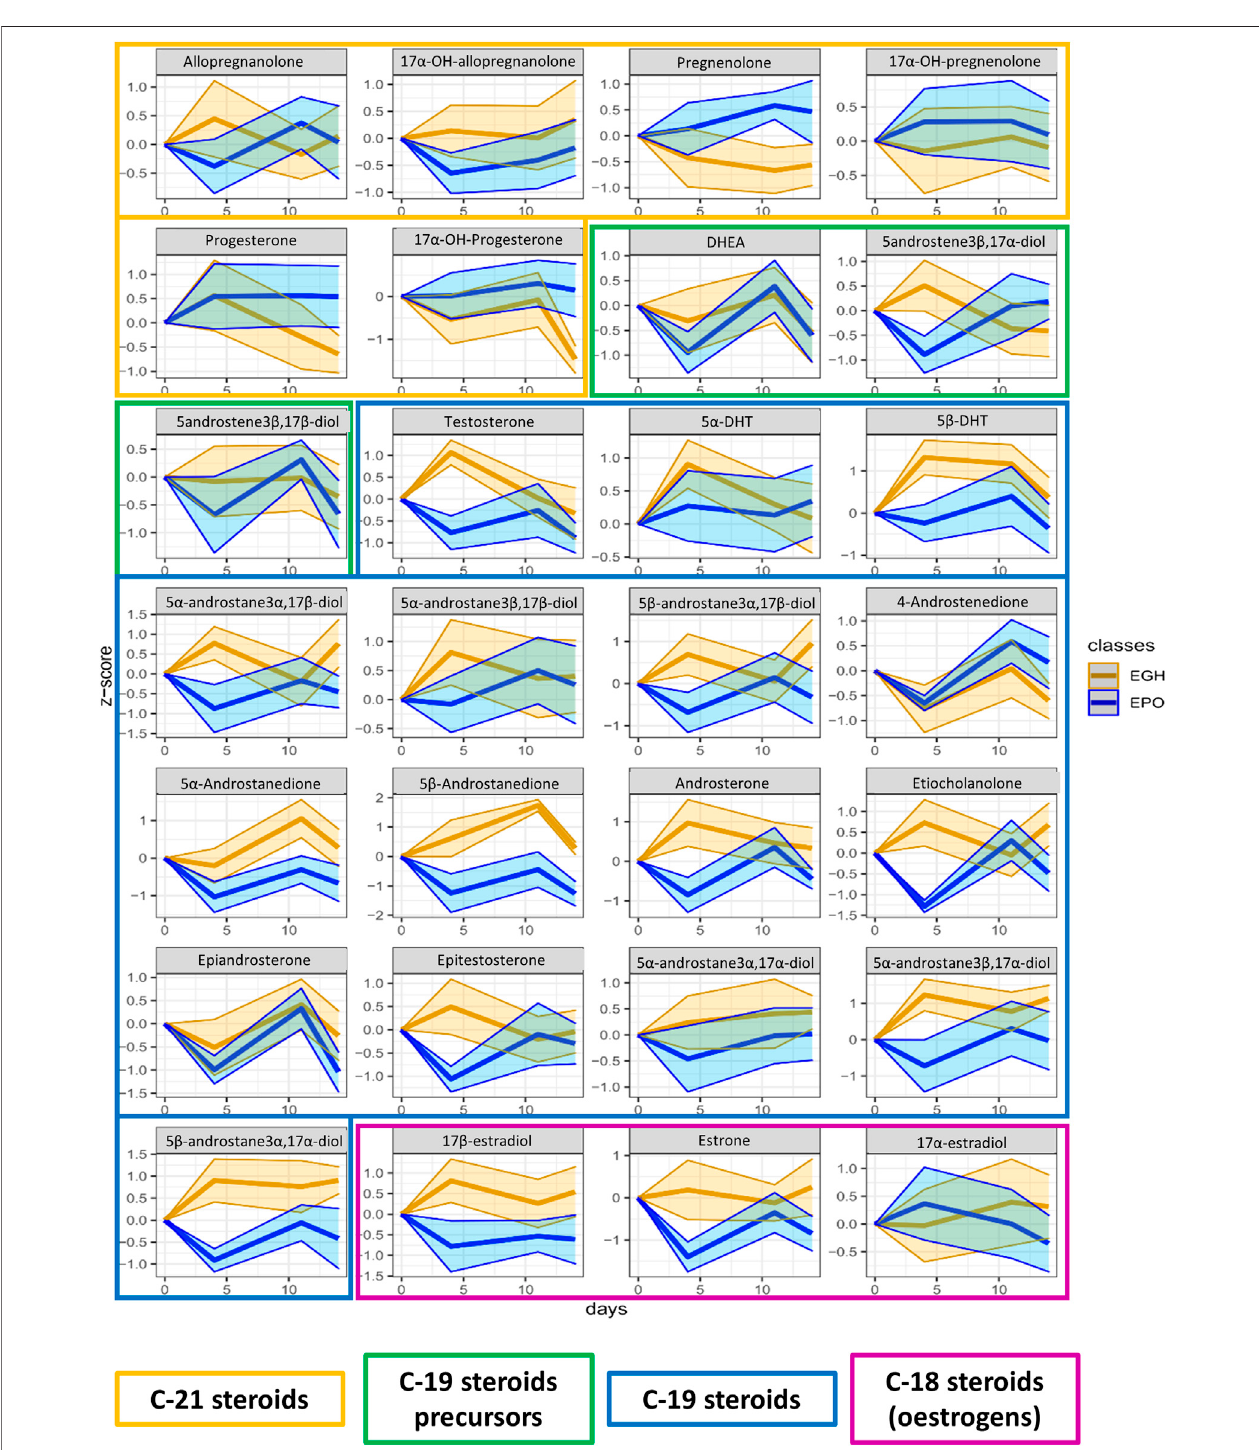
FIGURE 5 | Trend plots of the whole steroidomics pro fi le measured in the urine of the two groups (EPO in red and EGH in green). The colored areas represent the trends across the time-points. The area is measured as ± 1 standard deviation from the mean value.